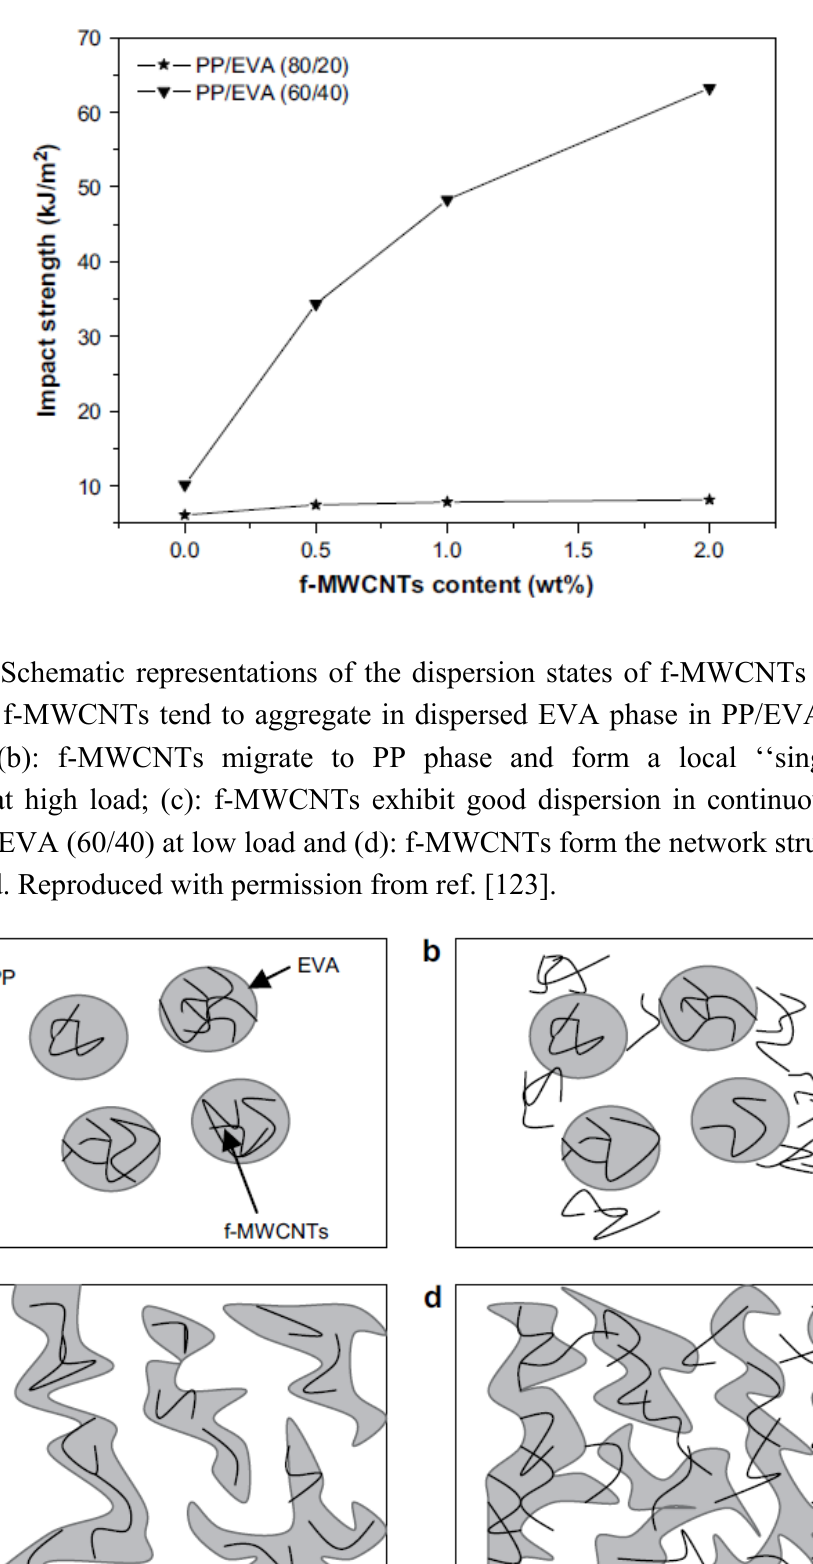
Figure 54. Notched Izod impact strength of PP/EVA blends with different contents of functionalized MWCNTs (f-MWCNTs). Reproduced with permission from ref. [122].